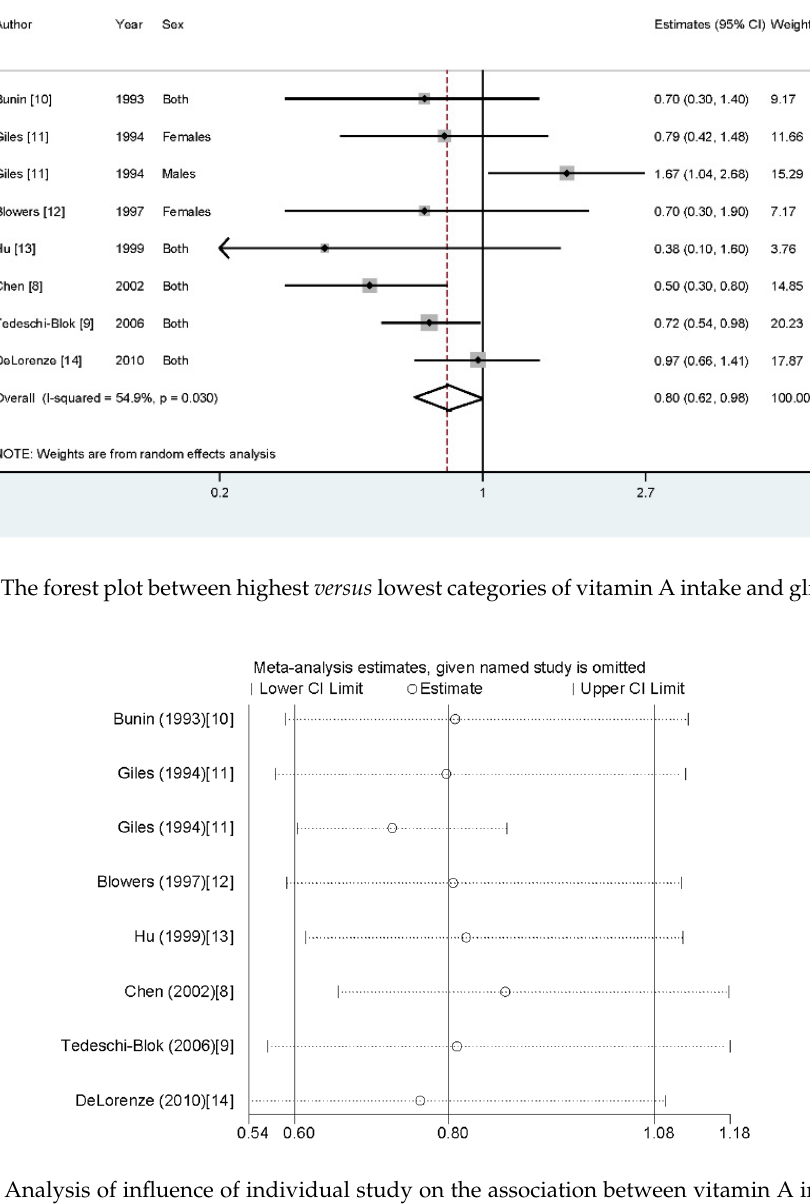
Figure 3. Analysis of influence of individual study on the association between vitamin A intake and glioma risk. Open circle indicates the pooled relative risk, given named study is omitted. Horizontal lines represent the 95% CI.